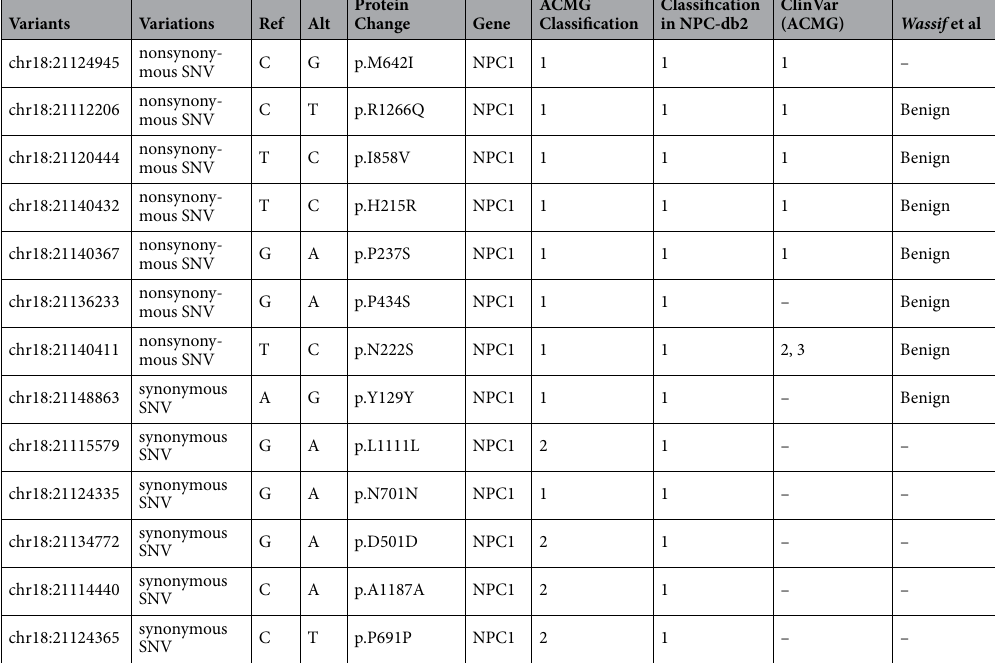
Table 3. Variants in the CARTaGENE RNA-seq sample excluded from the pipeline but identified in NPC-db2. a Classification 1: Benign 2: Likely benign 3: Uncertain significance 4: Likely pathogenic 5: